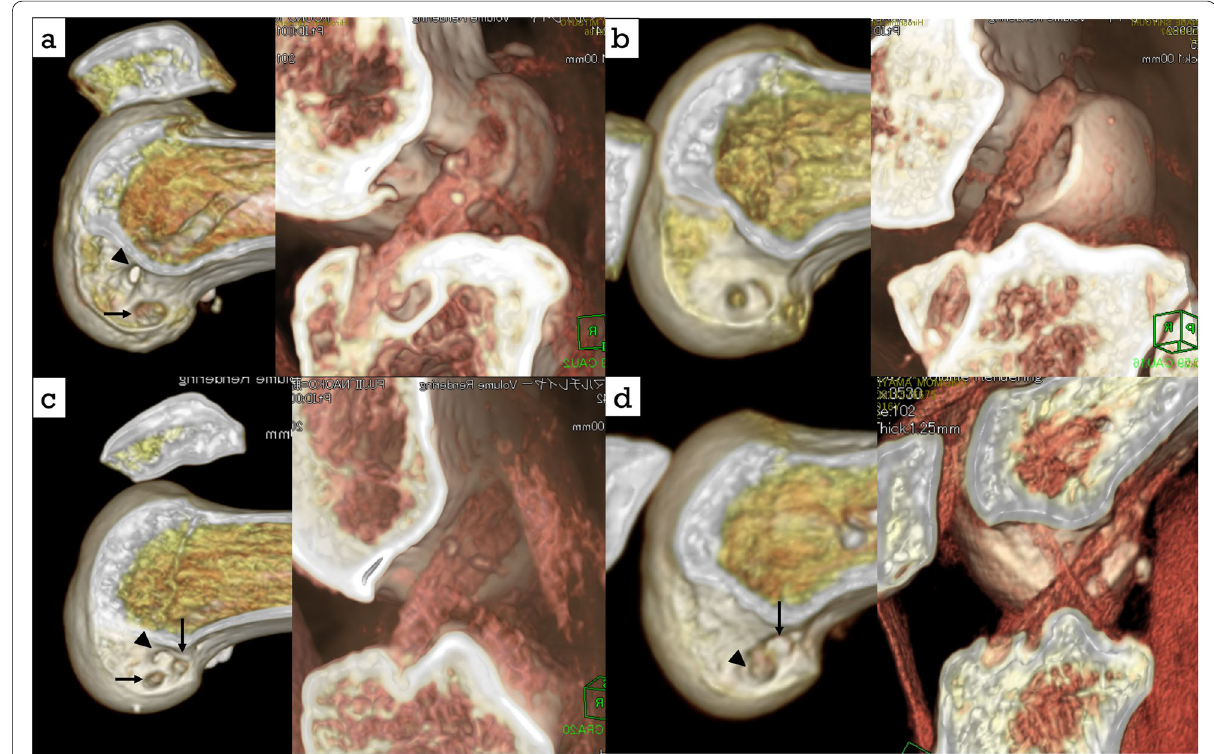
Fig. 2 Operative procedure. a , Single (Mal-position): A primary bone tunnel (arrow head) was mal-positioned and a new single bone tunnel (arrow) was created. b , Single OTTR (Enlargement of primary bone tunnel):A new bone tunnel could not be created due to enlargement and the OTTR procedure was chosen. c , Single-Double (Mal-position):A primary bone tunnel (arrow head) was mal-positioned and new bone tunnels (arrow) of AM and PL bundle were created. d , Single-Double / AM OTTR (Re-injury case); We chose to use a primary tunnel (arrow head) for PL bundle. OTTR was selected for AM bundle because there was a risk of coalition when a primary AM tunnel (arrow) was used. The femoral side was fixed with a staple in the OTTR procedure and with Endo-Button CL in the bone tunnel procedure, and the tibial side was fixed with a staple in all